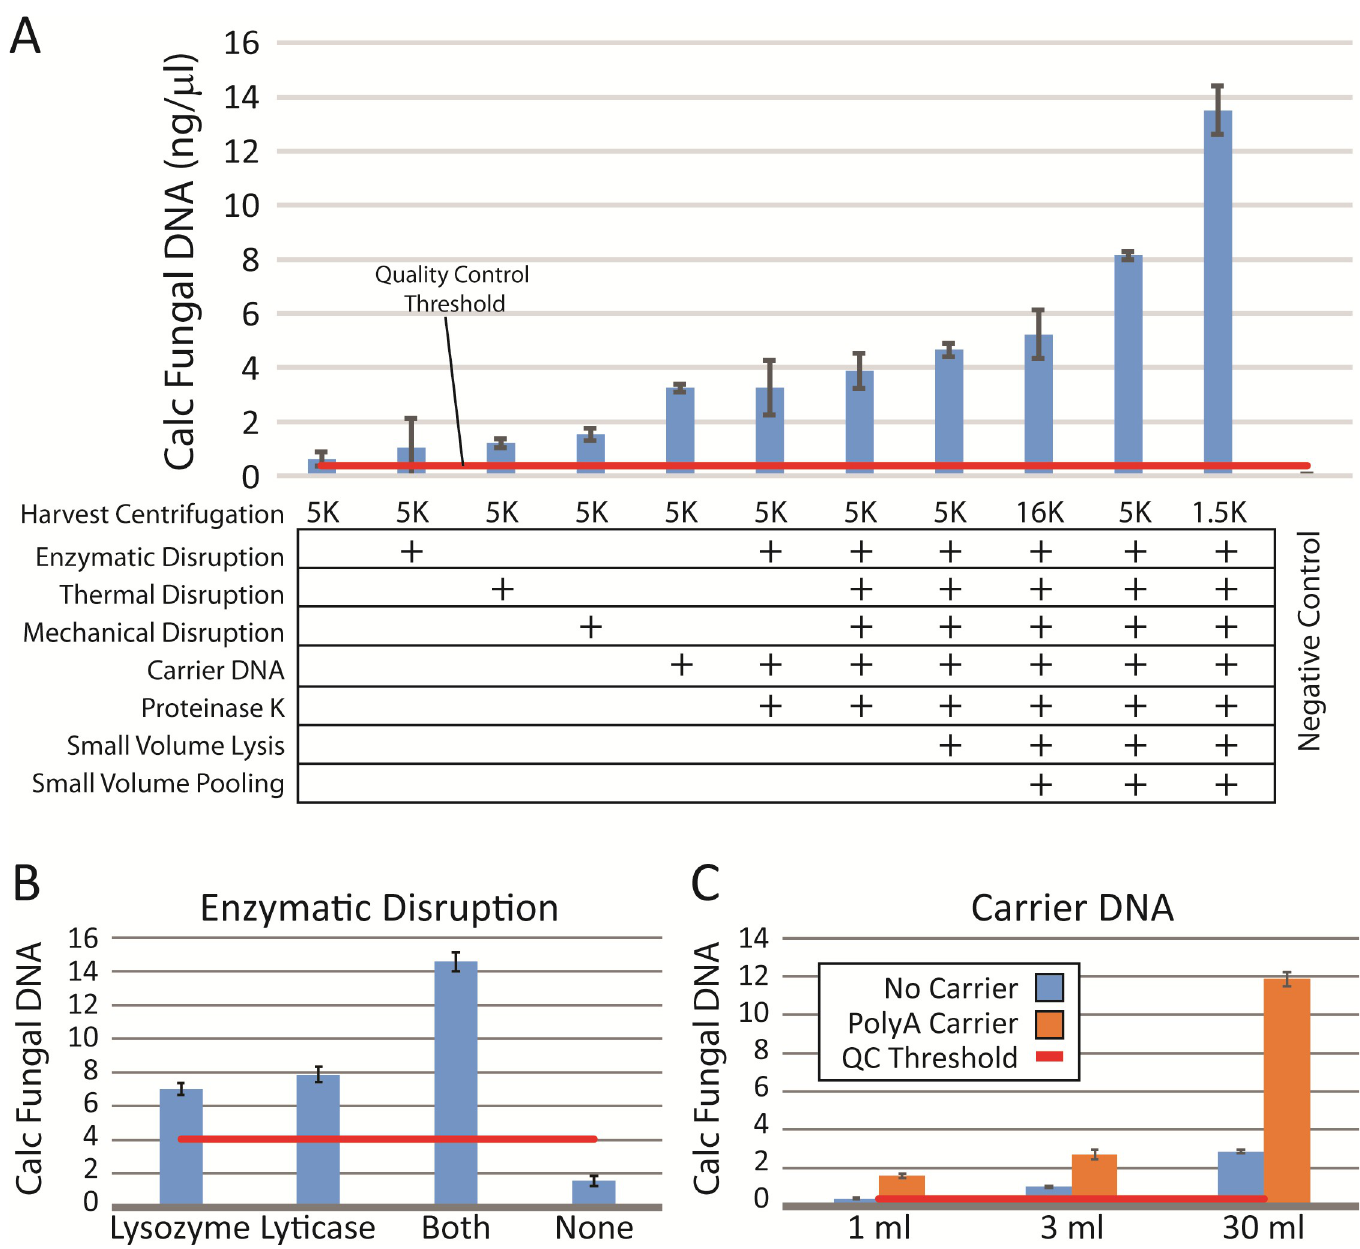
Fig 1. Optimization of microbial dna extraction requires multiple disruption steps. (A) Eight variations in the protocol (at left) were noted to increase yields as determined by quantitative PCR. Relative fungal DNA yields were calculated from quantitative PCR using the Fungiquant pan-fungal PCR primer pair and normalized to a mixed fungal DNA standard. The negative control samples were processed in parallel, but did not have any input cellular material. Multiple protocol variations, such as enzymatic pre-digestion (B) or carrier DNA use during DNA column binding (C), were tested individually in triplicate for multiple subjects (minimum n = 4), both male and female, before